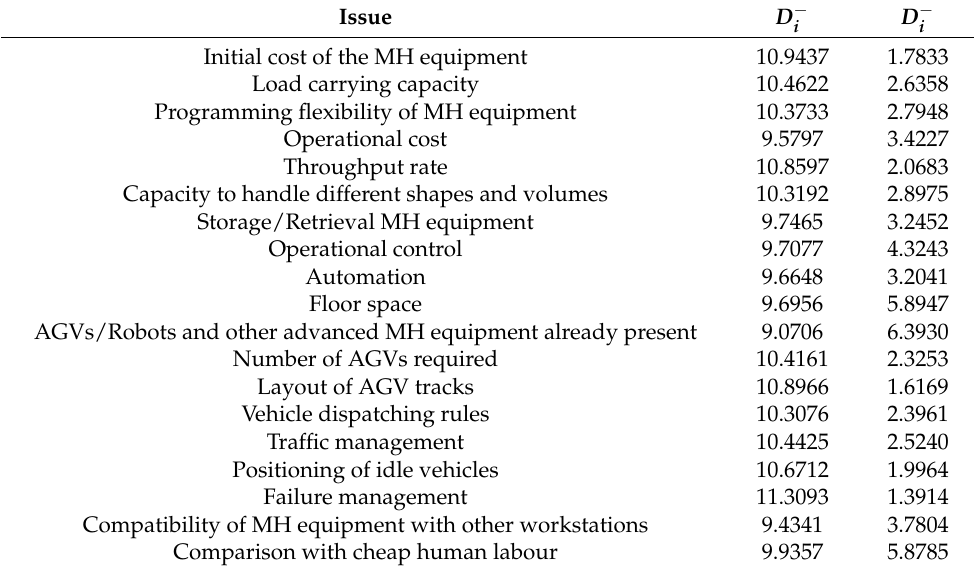
Table 24. Distance of ideal and nadir issue from weighted data.